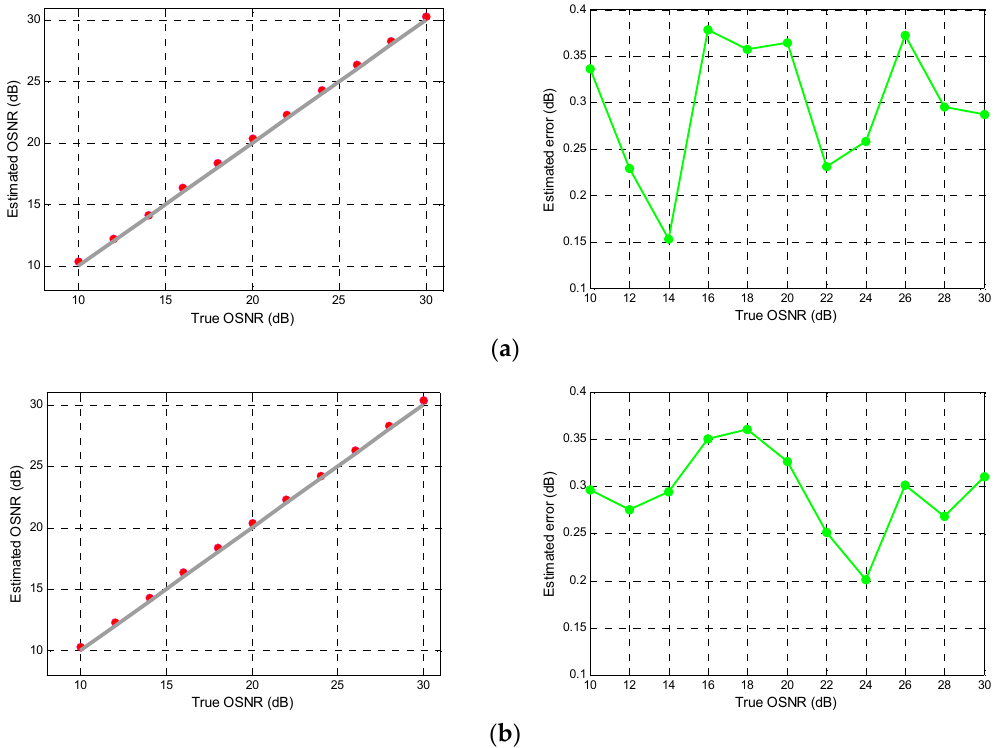
Figure 10. True versus estimated OSNRs and errors for PM-RZ-QPSK signal with ( a ) 100 bin numbers and ( b ) 55 bin numbers using PSO-DNN in different OSNRs.